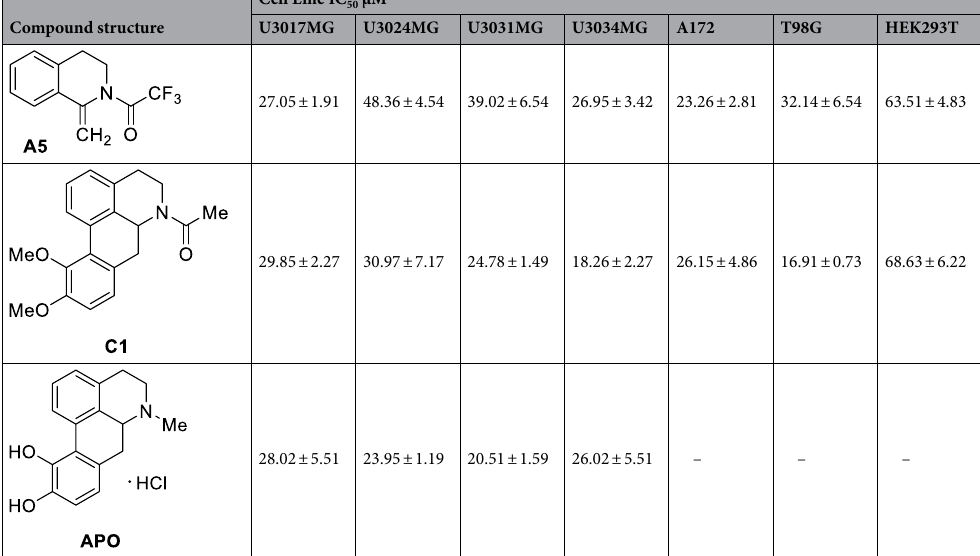
Table 1. Chemical structures and IC 50 values of A5, C1 and APO on the cell